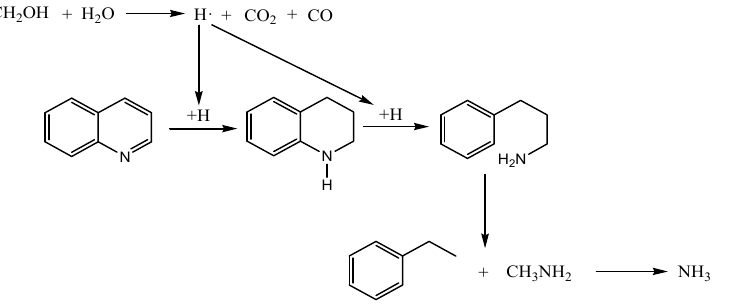
Figure 15. Aquathermolysis reaction mechanism of quinoline. The GC curves of benzothiophene under different reaction conditions are shown in Figure 16. The product was ethylbenzene by GC-MS analysis. The mechanism of the benzothiophene reaction is shown in Figure 17. Benzothiophene first undergoes hydrogenation to form 2,3-dihydro-1-benzothiophene, followed by C-S bond breaking and ring opening to produce ethylbenzene and hydrogen sulfide [38].